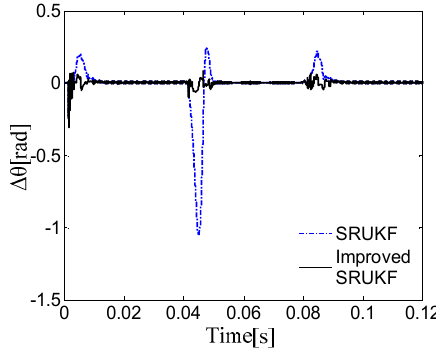
Figure 10. Space position estimation error at speed step response.